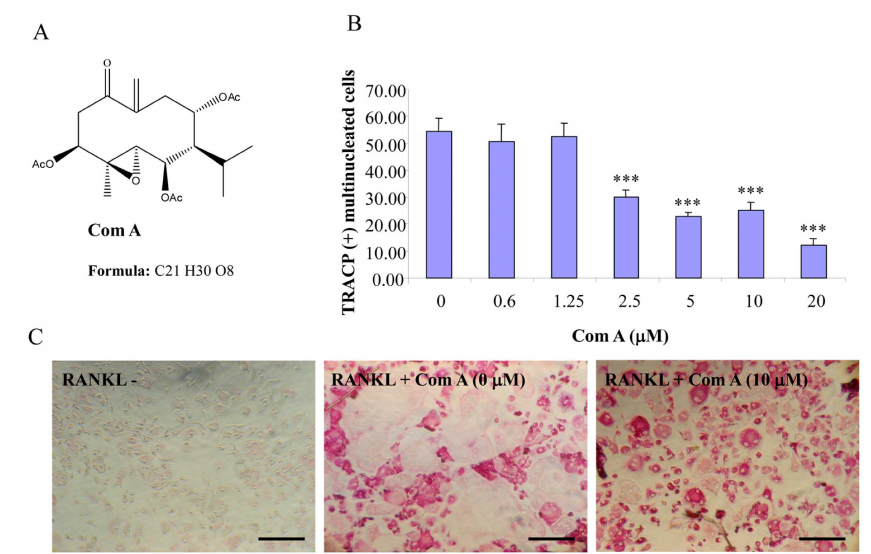
Figure 1. Compound A inhibits RANKL-induced osteoclastogenesis. ( A ) Chemical structure of compound A; ( B ) mouse BMMs cultured in a 96-well plate in the presence of RANKL (100 ng/mL) and M-CSF (10 ng/mL) with or without compound A for five days were fixed with 4% paraformaldehyde and stained for TRACP activity. Quantitative analysis shows the mean number of TRACP-positive multinucleated cells (MNC). (*** p < 0.001 compared to RANKL treated control, n = 3); and ( C ) representative light microscope images showing the effect of compound A on RANKL-induced osteoclast formation. (Mag = 20 ˆ , scale bar = 100 µ m).